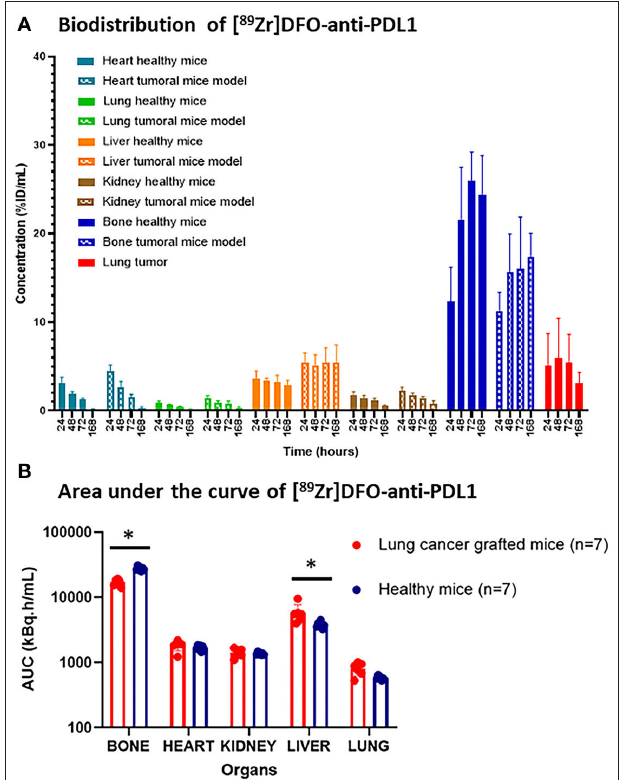
FIGURE 2 | Biodistribution and area under the concentration curve of [ 89 Zr]DFO-anti-PDL1 in healthy and lung cancer-grafted mice. (A) Biodistribution of [ 89 Zr]DFO-anti-PDL1 in both healthy and lung cancer-grafted mice. (B) Area under the concentration curve up to 168h after injection (AUC 0–168h) for each organ in healthy and lung cancer-grafted mice. Wilcoxon-Mann-Whitney test (* p < 0.05). AUC, the area under the curve.